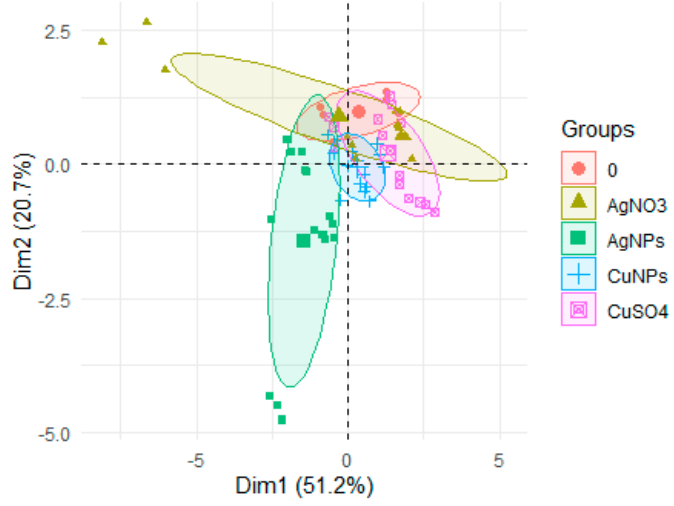
Figure 6. PCA for di ff erent chemical compounds (AgNO 3 , AgNPs, CuSO 4 , CuNPs) in the rainbow Figure 6 PCA for different chemical compounds (AgNO 3 , AgNPs, CuSO 4 , CuNPs) in the rainbow trout eggs and trout eggs and fry.